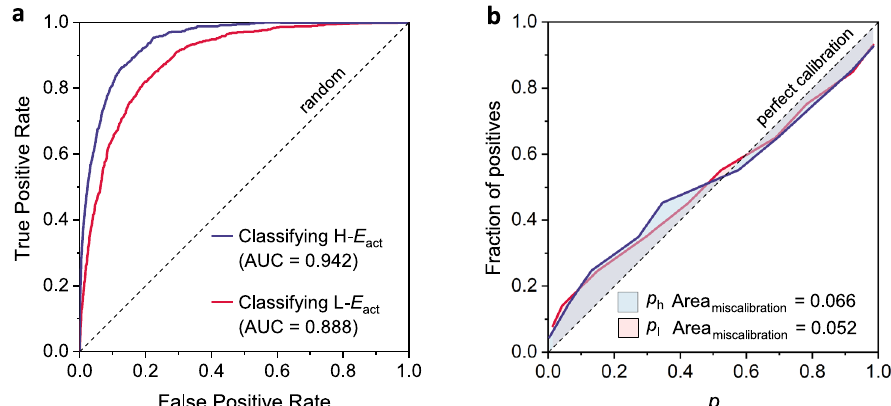
Fig. 2 Predicting the heterogeneity of thermally activated events. a Receiver operating characteristic (ROC) curve and area under curve (AUC) in classifying the atoms showing the highest 5% (H- E act problem) or lowest 5% activation energy (L- E act problem). The dashed line marks a random case. b Near-perfect calibration of the ML-evaluated class probability estimates, that is, p h from H- E act and p l from L- E act